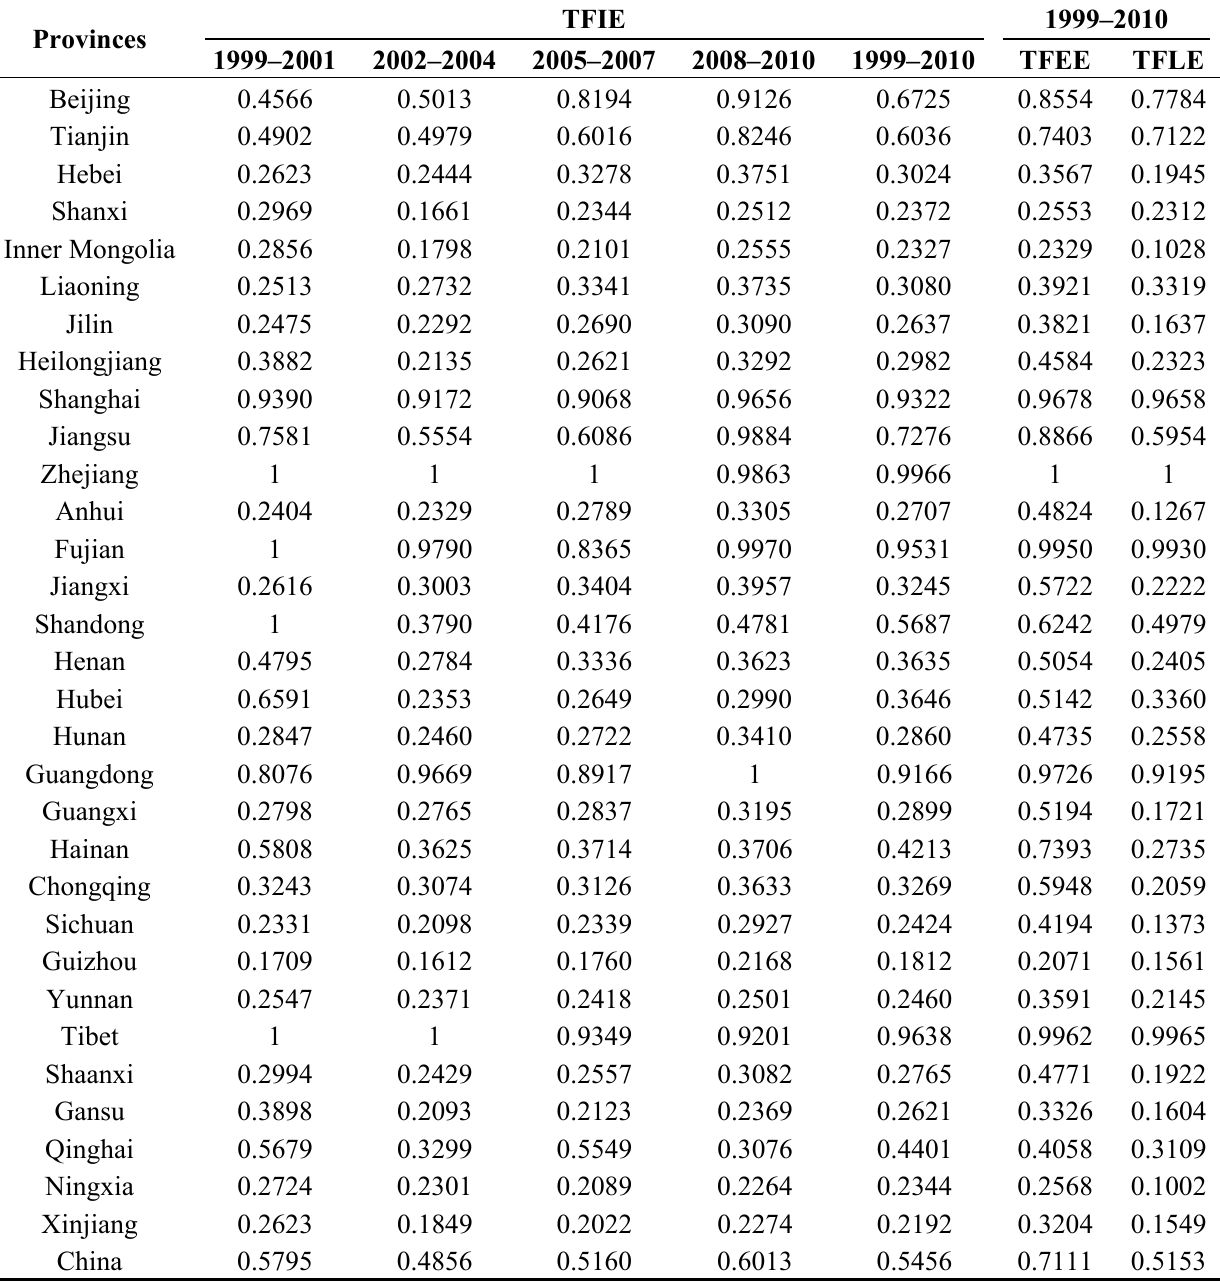
Table 2. Local TFE in China estimated by the target Model